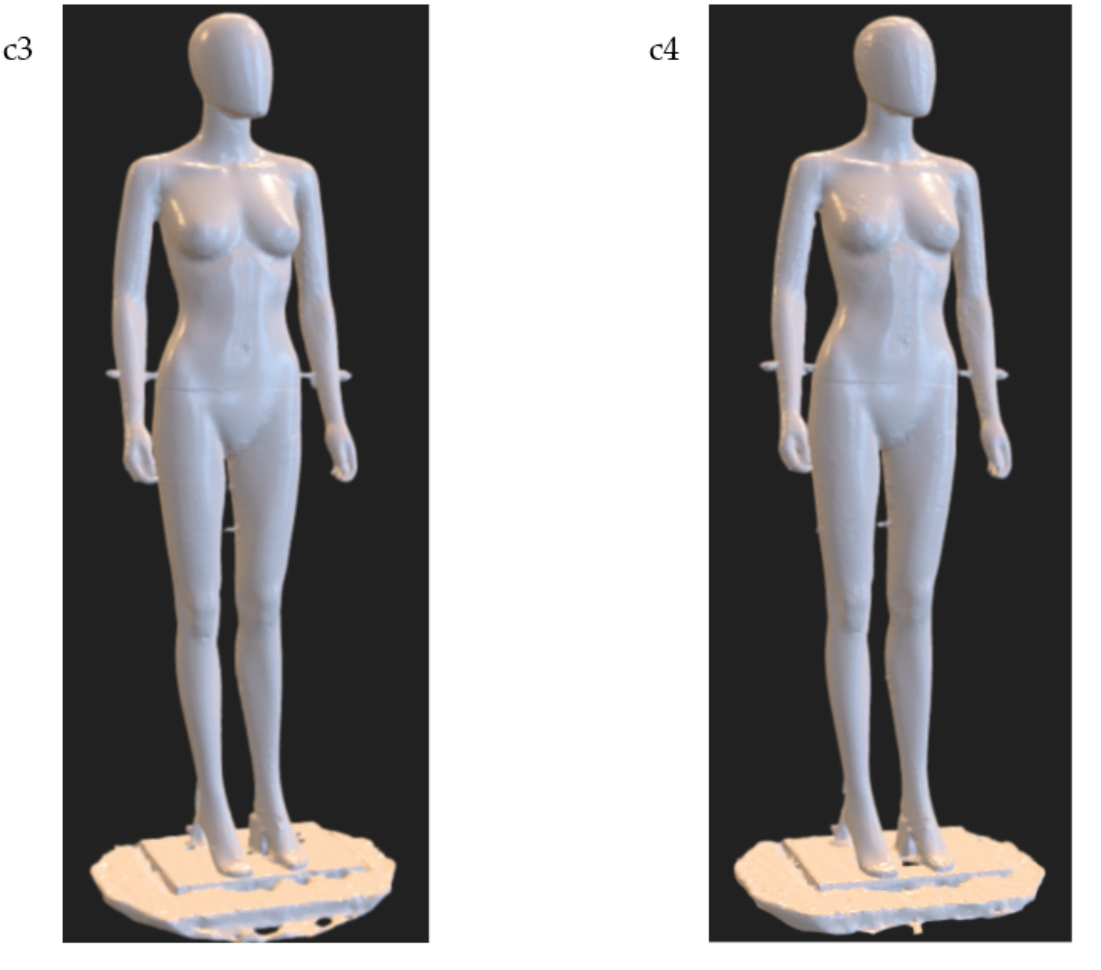
Figure 13. The 3D models in the form of a triangle mesh obtained for variants c3 and c4 of the experimental tests of the HUBO scanner,